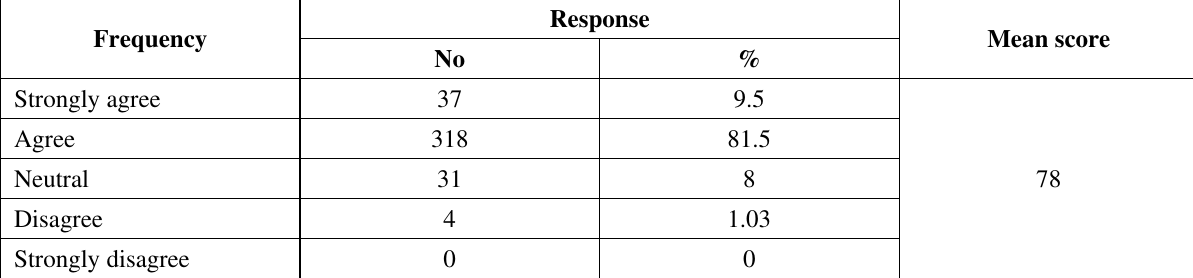
Figure 4. Theoretical proposition 4: policy framework